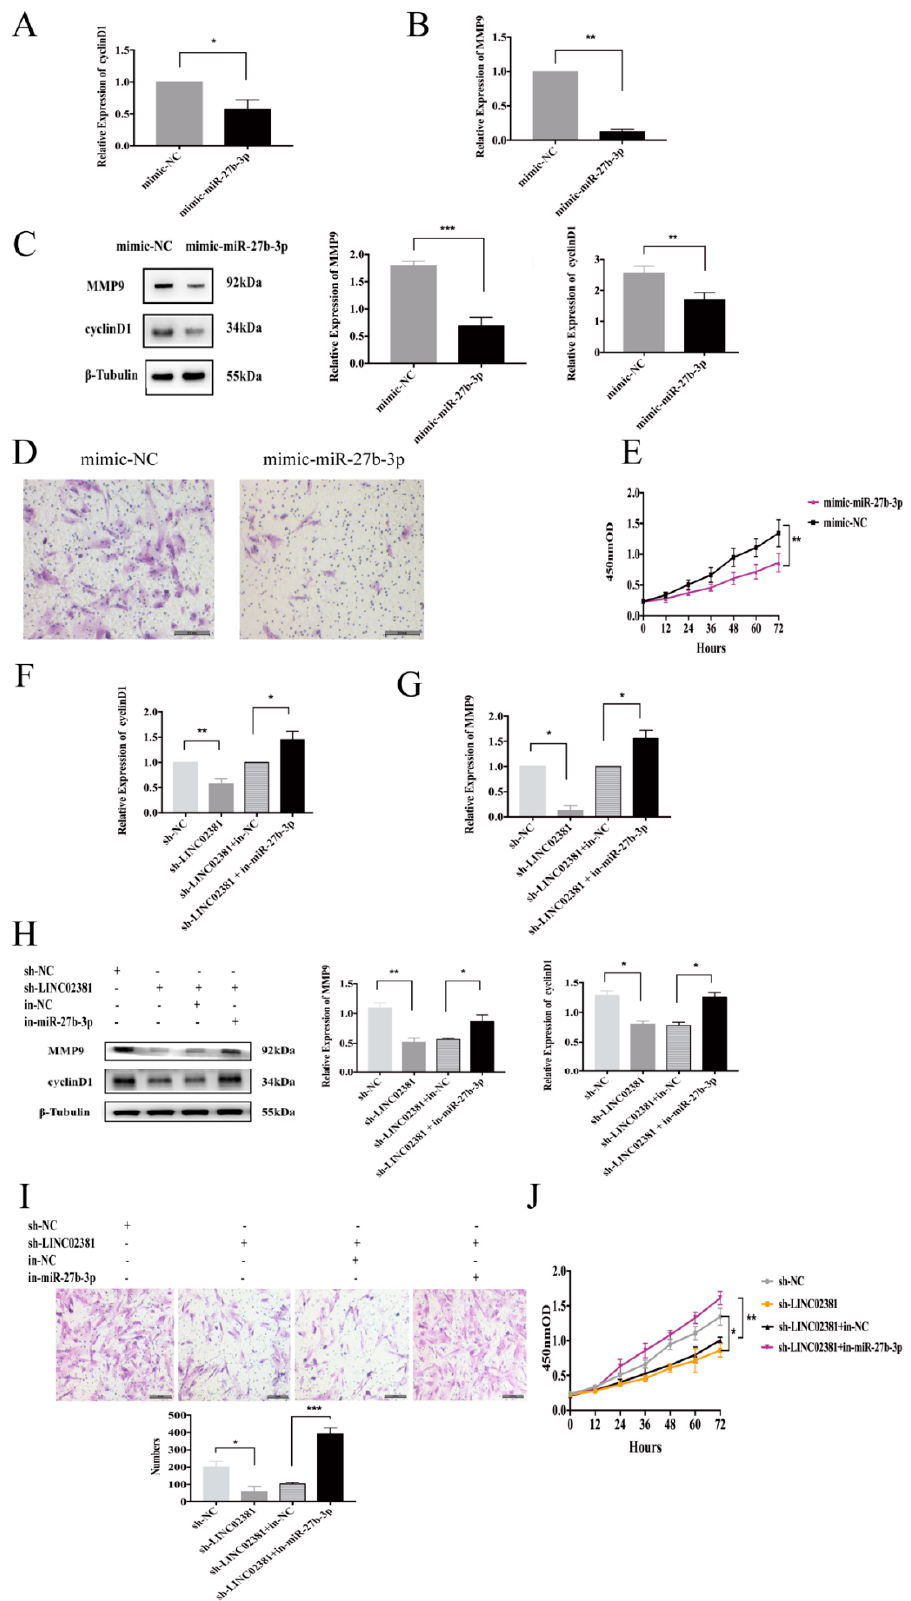
Figure 5. The LINC02381/miR-27b-3p/CTNNB1 regulatory axis. ( A , B ) ESCs were harvested for qRT-PCR after miR-27b-3p expression was increased to quantify the mRNA expression of cyclinD1 (n = 3, P < 0.05) and MMP9 ( n = 3, P < 0.01). ( C ) ESCs were harvested for Western blot analysis after mimic-miR-27b-3p/mimic-NC was added to determine the protein expression of cyclinD1 ( n = 3, P